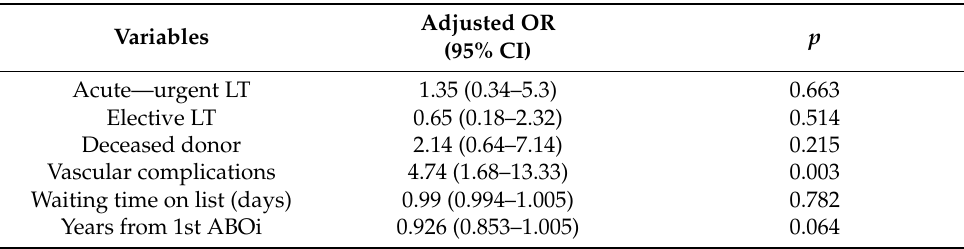
Table 6. Risk factors for graft loss. Multivariable analysis (logistic regression): only factors with p -value < 0.1 according to a univariate analysis were included.